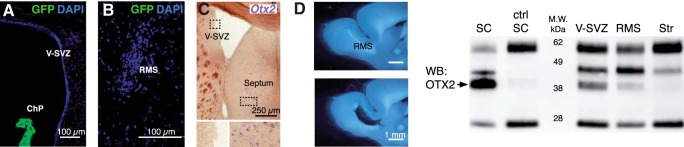
OTX2 in RMS and V-SVZ is non-cell-autonomous. A–C, Absence of Otx2 expression in V-SVZ (A, C) and RMS (B), as shown by GFP staining in coronal sections of Otx2+/GFP mice (A, B) and by in situ hybridization for Otx2 mRNA in coronal sections of wild-type mice (C). Note the expression of GFP in choroid plexus (A) and of Otx2 in septum (C). D, Representative sagittal section of RMS microdissection. E, Western blot (WB) analysis of OTX2 immunoprecipitation from lysates of various brain regions (ctrl, IgG control). Bands include OTX2 (<40 kDa), IgG (25 and 55 kDa), and unknown (∼45 kDa). SC, Superior colliculus; Str, striatum; M.W., molecular weight.